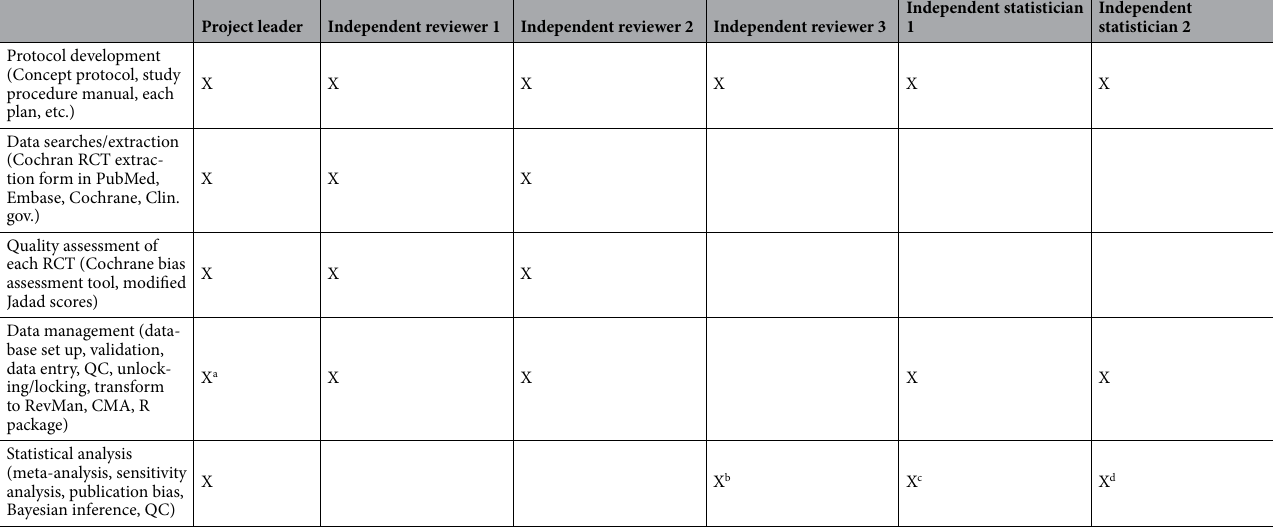
X X X X X X X X X a